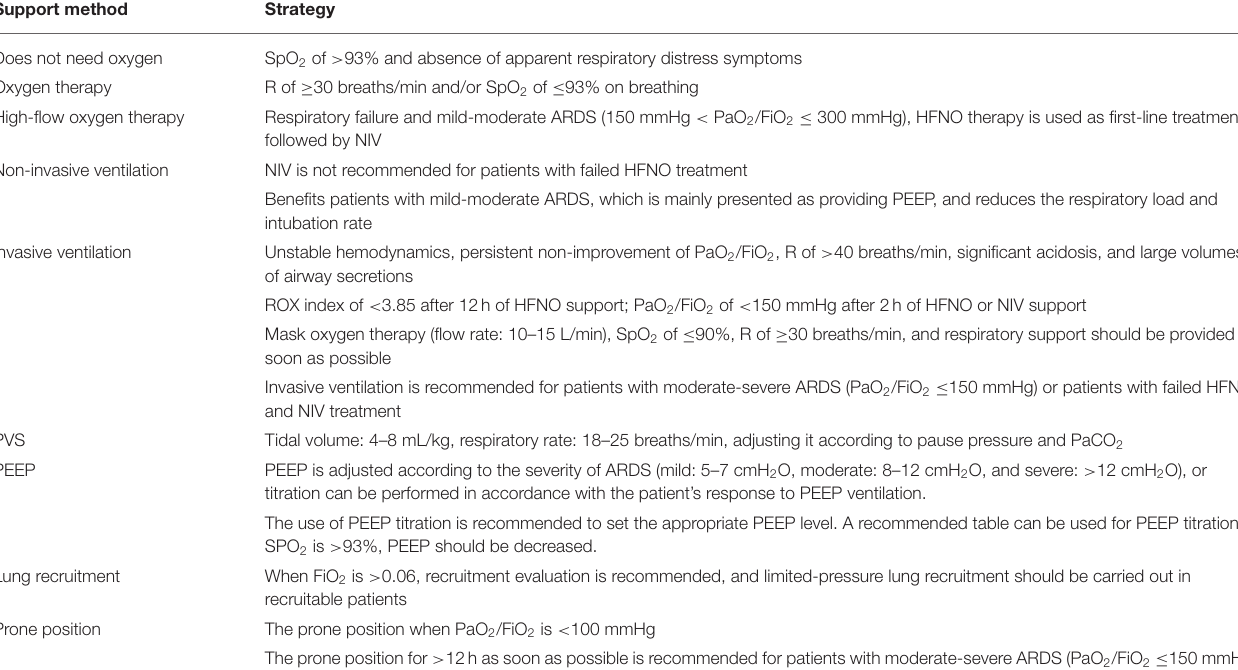
TABLE 1 | Respiratory supportive treatment for